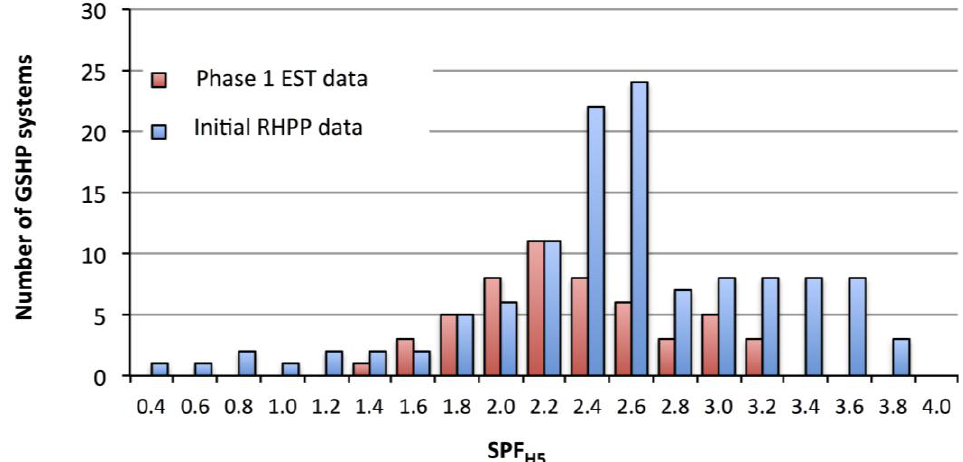
Figure 7. Seasonal Performance Factor data (SPF programme data [47] and compared with the Energy Saving Trust (EST) national field trial Phase 1 data [71]. Data from [47,71].